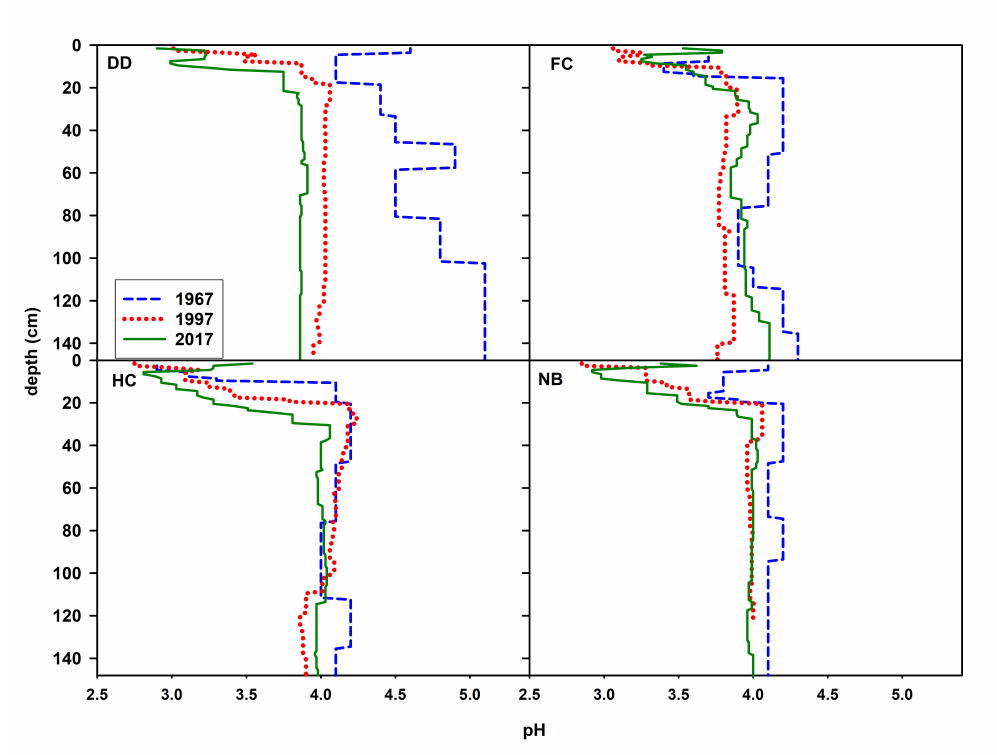
Figure 1. Soil pH profiles with depth. At each site, there was one profile in 1967. In 1997 and 2017, four soil profiles were sampled at each site. The profile shown for these years was calculated as the average in one cm increments. The 1967 profile is shown in a dashed blue line, 1997 as a dotted red line, and 2017 as a solid green line. The same format is followed for the other chemistry profile figures (Figures 2–5). The supplemental Figure S2 shows each chemical profile individually, i.e., four profiles per site in each of 1997 and